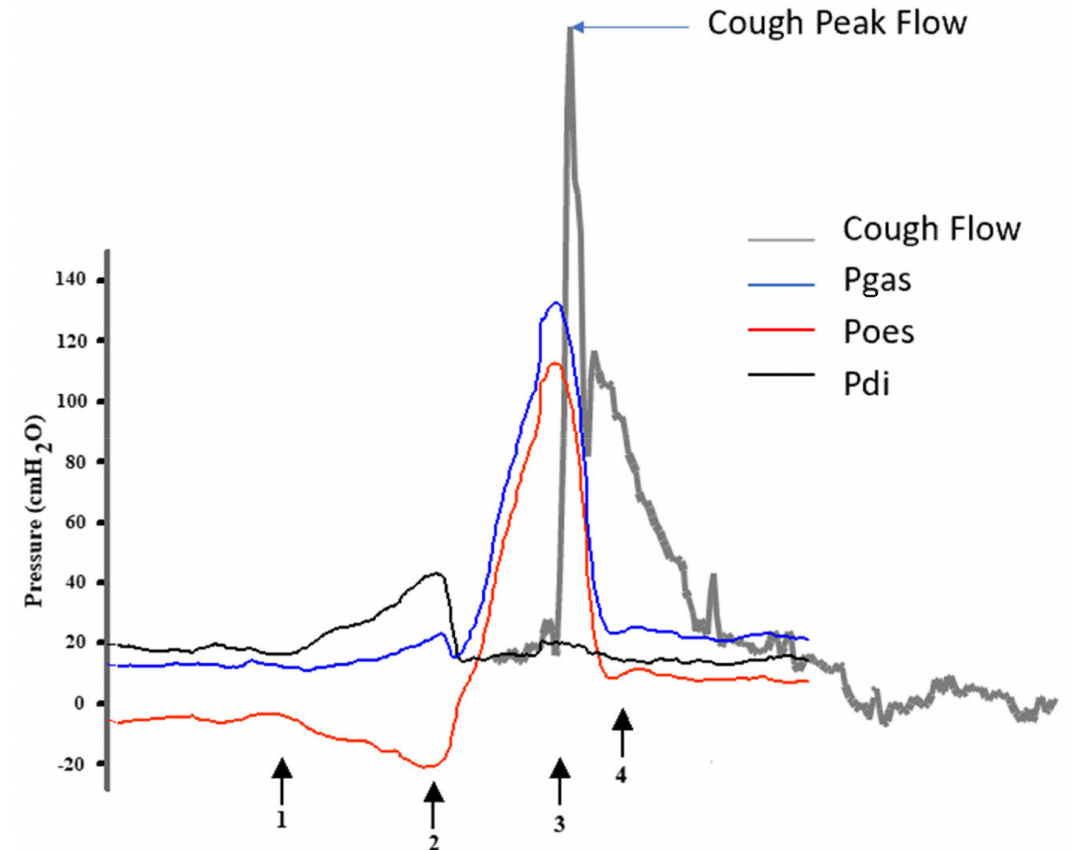
Figure 1. Shows the components that occur within a normal cough. Blue represents the gastric pressure, red is the esophageal pressure, and black is the transdiaphragmatic pressure. Superimposed on this in grey are the flow changes that are seen during a cough. Arrow 1 indicates the start of the deep inspiration. Arrow 2 is the forced expiration against a closed glottis. Arrow 3 is the sudden opening of the glottis and Arrow 4, compression of the intra-thoracic airways. Cough peak flow (CPF) is measured as the peak expiratory flow that occurs during a cough. For anyone over the age of 12 years old, a CPF that exceeds 360 L/min is deemed to be normal. There are reference values for children